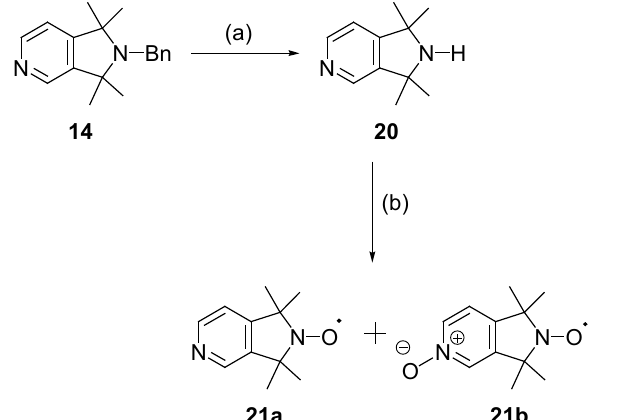
/Pd/C, MeOH, rt, 3-4 h, 95%; (b) H 2